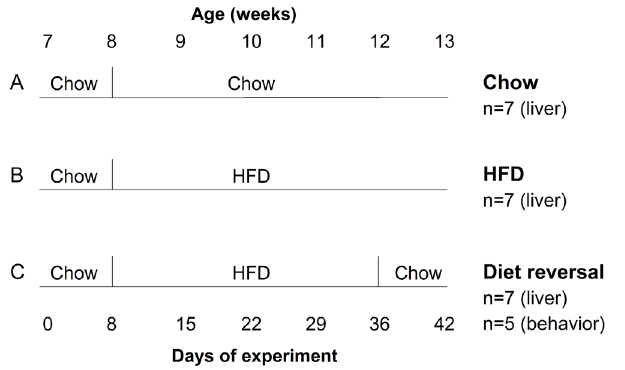
Fig 1. Experimental Protocol Diagram. Male heterozygous PER2::LUC mice were single-housed in light- tight boxes (12L:12D) at 7 weeks old and fed either chow for 5 weeks (A), high-fat diet (HFD) for 5 weeks (B), or HFD for 4 weeks and then chow for 1 week (C). At 13 weeks old, bioluminescence rhythms were measured from liver explants (n = 7/group). Eating and locomotor activity rhythms were also measured in the diet reversal group (C, n =